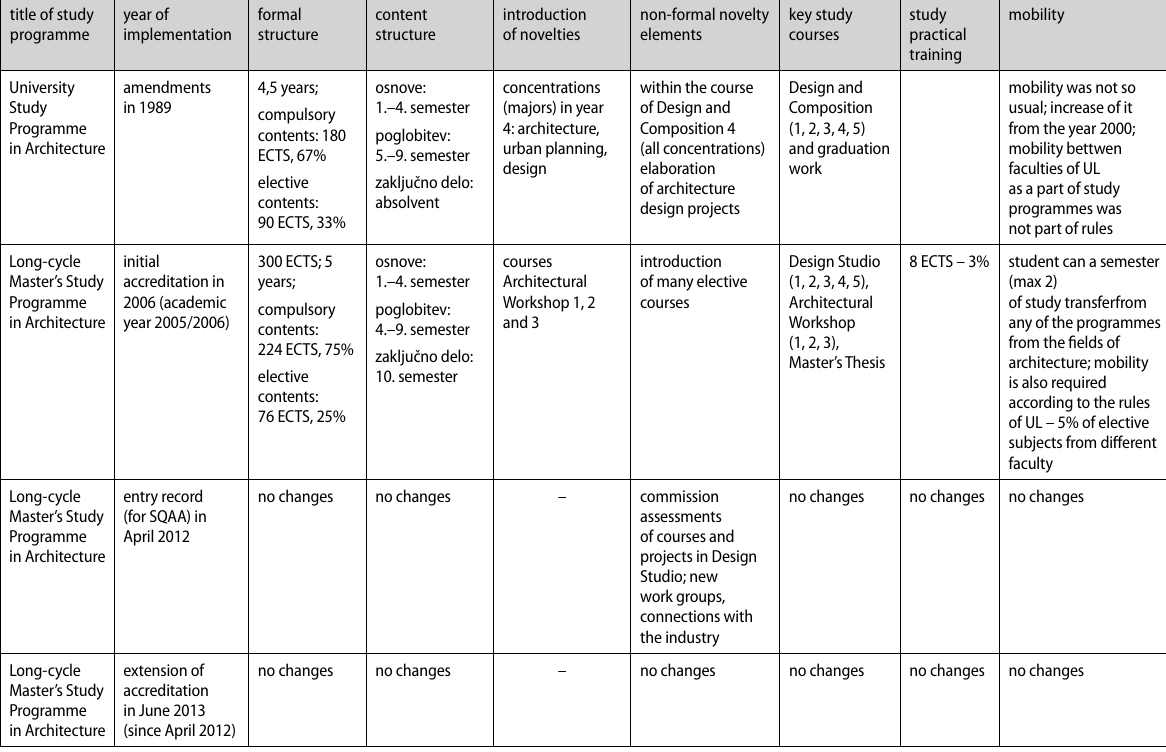
Table 2. Changes in education of architecture at ul fa and the key elements of the study